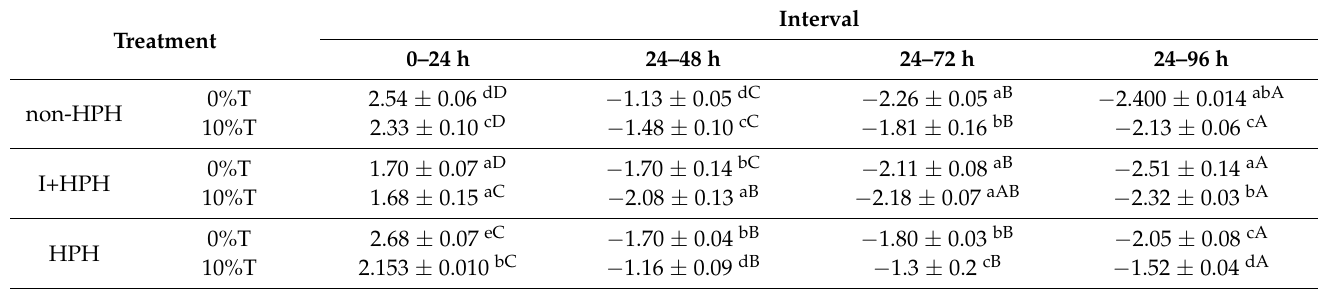
Table 1. Log increase (values > 0) or log decrease (values < 0), respectively, showing the L. salivarius spp. salivarius CECT 4063 growth or demise from the juices along their